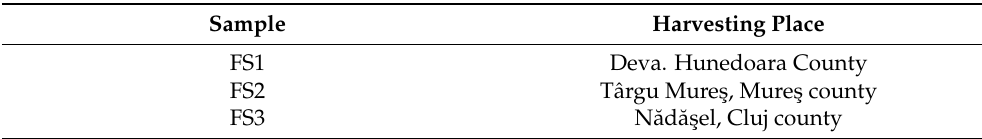
Table 6. The collected F. schleicheri samples and their harvesting place.